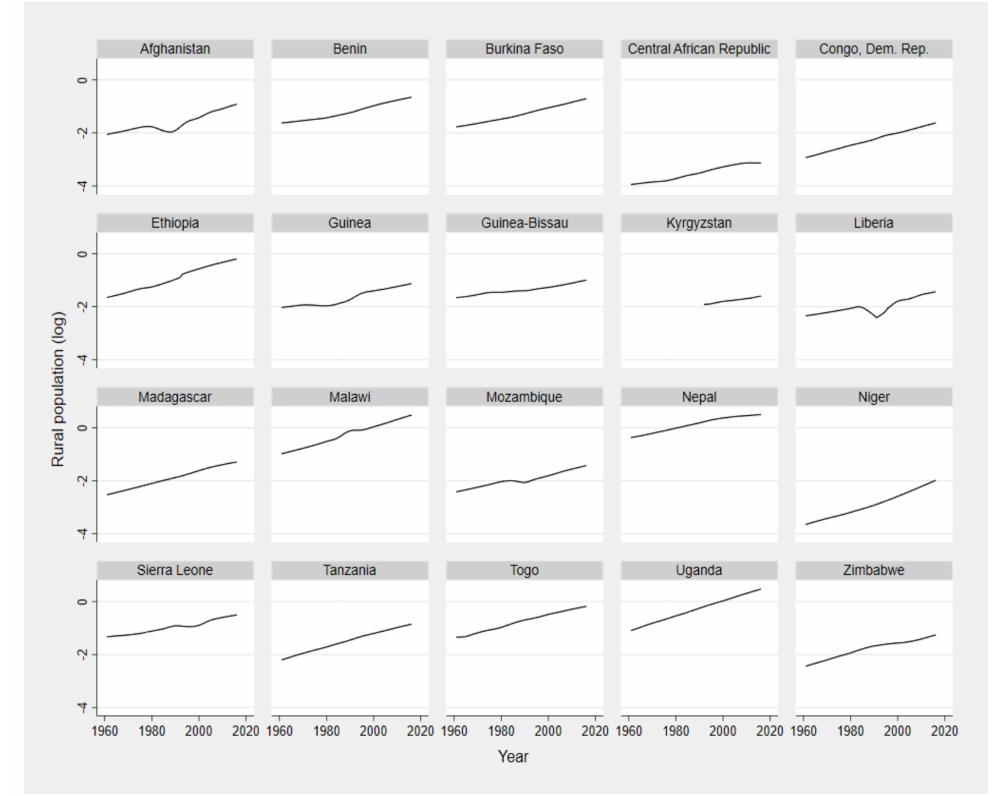
Figure A14. Temporal evolution of rural population density, low-income